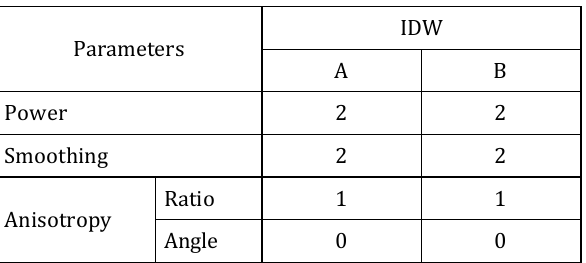
Table 2. Parameters used for the inverse distance weighting (A – the heap surface, B – interior of the heap)